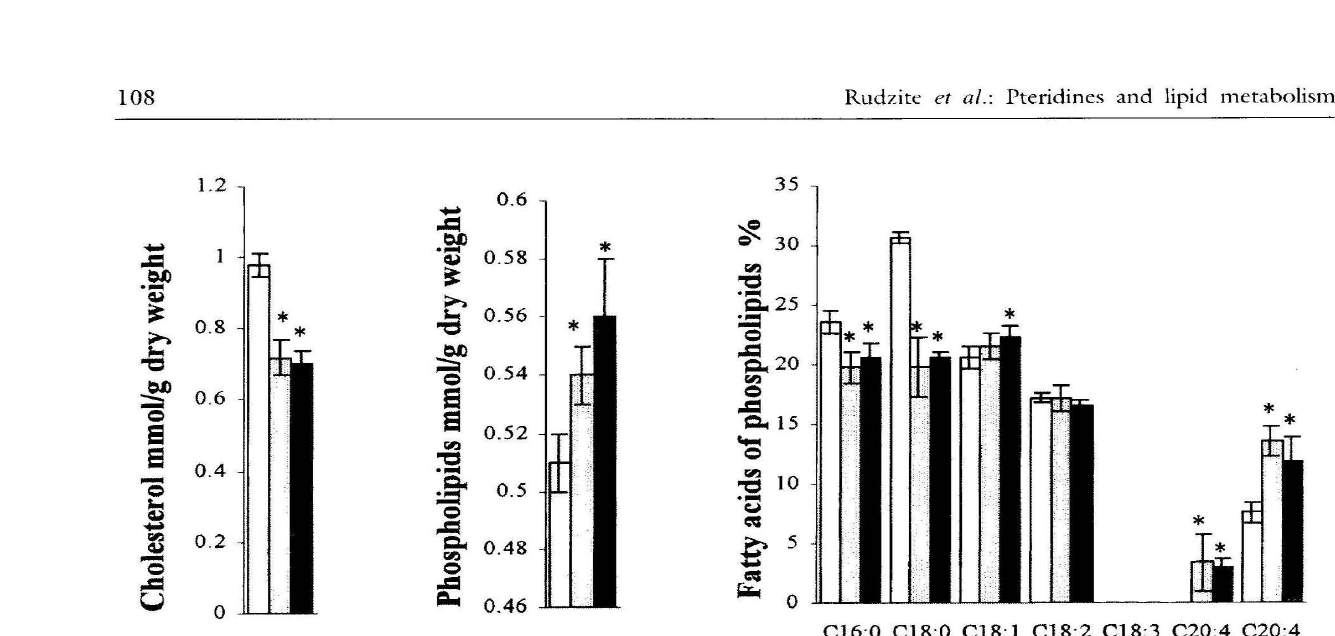
Figure 7. Concentrations (mean±S.D .) of cholesterol and phospholipids, as well as fatty acid content (in percent: mean±S.D. ) in controls (open bars) and in samples with 5 pmoljg wet weight monapterin (dotted bars) and 30 pmol/ g wet weight monapterin (hatched bars). Samples of rat liver tissue homogenates were used to test for phos pholipid biosynthesis in vitro. Incubation medium: Krebs-Ringer-phosphate buffer, containing 0.3% albumin (pH=7.4), fatty acid mixture and glyceroL Samples were incubated twice for 4 h at 37"C. *The changes are statistically significant (p<0.05-p<0.001).